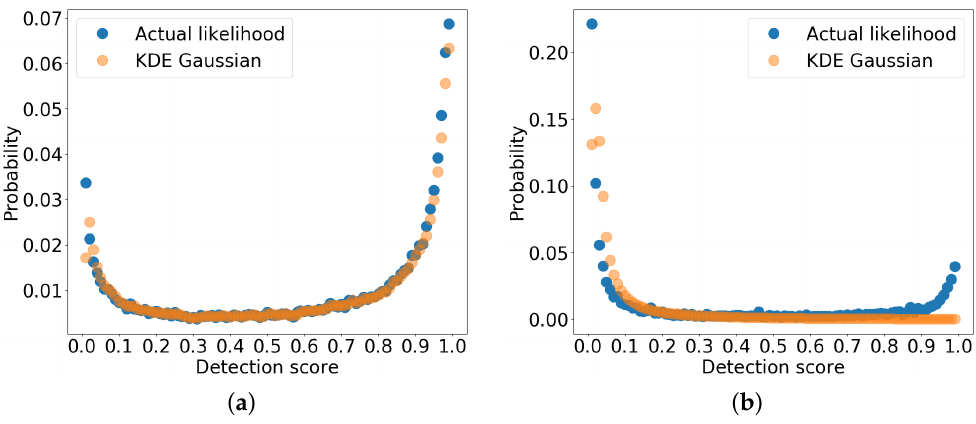
Figure 4. Estimated likelihood from a dataset category. ( a ) True positives likelihood- p x ( s | ped , G ) . ( b ) False positives likelihood- p x ( s | ∼ ped , G )